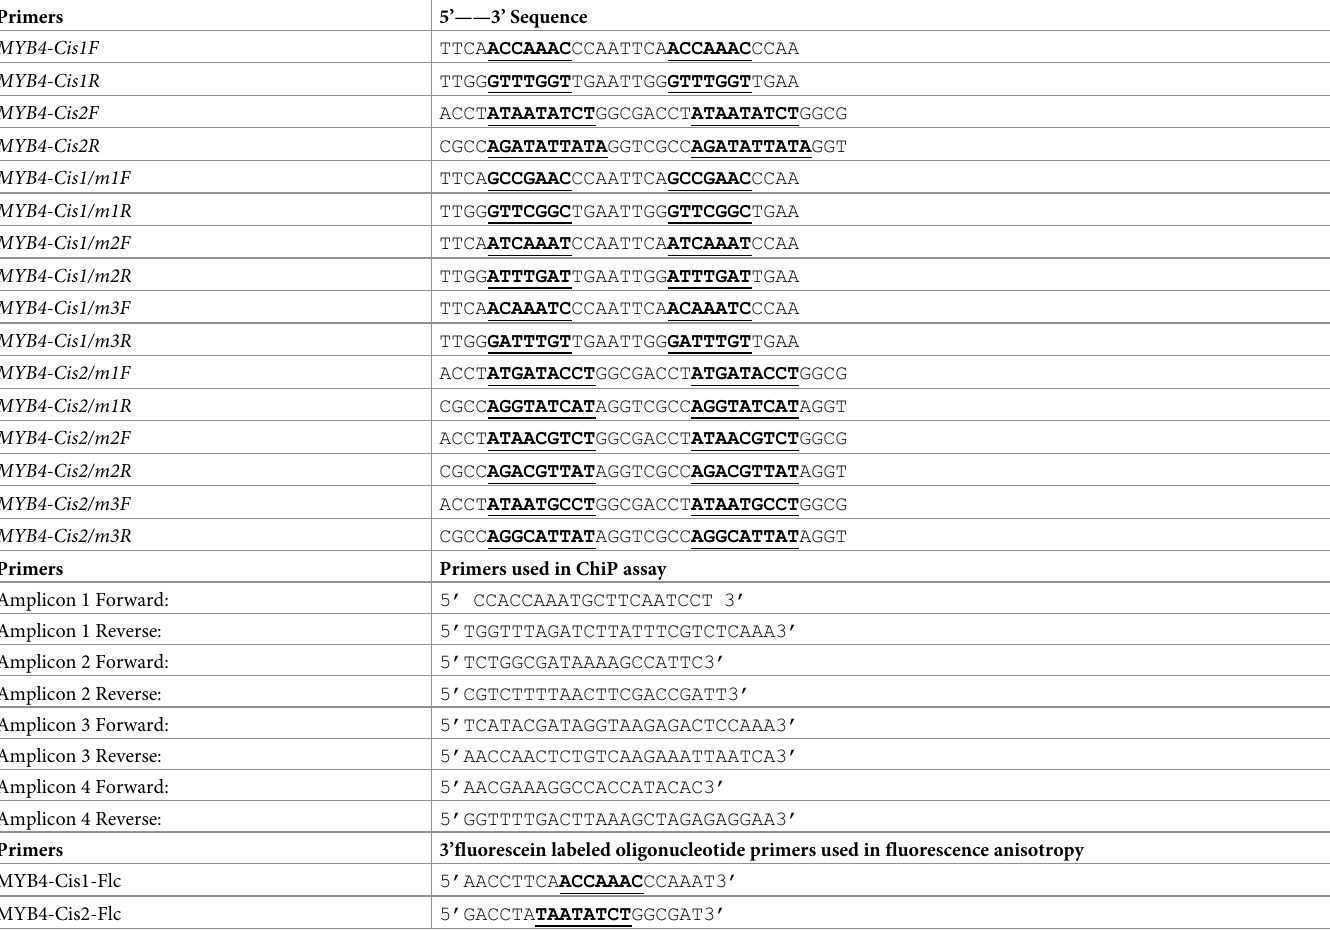
Table 4. Primer sequences used for gel mobility shift assay, chromatin immune-precipitation and fluorescence anisotropy.